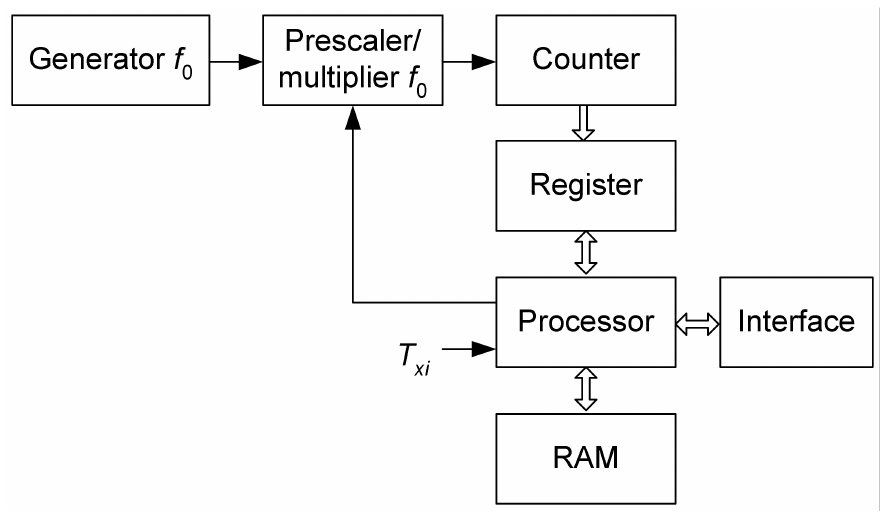
Figure 7. Structure of the f/N converter enabling the implementation of the adaptive